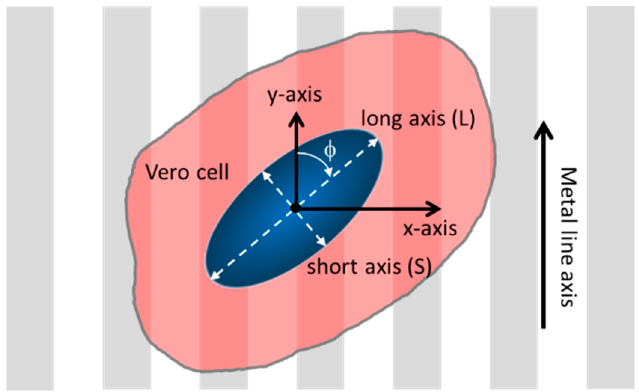
Figure 2. Schematic drawing of a cell on patterned comb structure and their orientation and elongation parameters. elongation